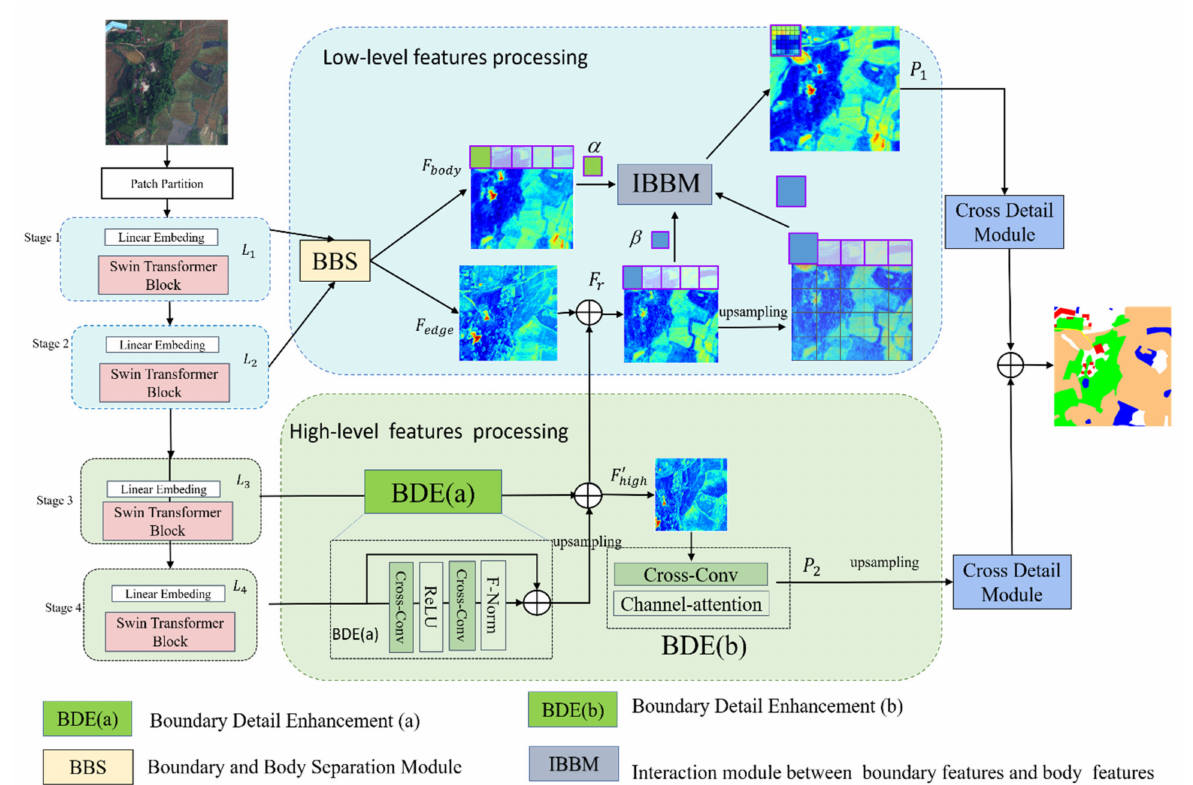
Figure 3. Overall structure of HBRNet. The figure shows the main modules for processing high-level features and low-level features. After inputting the original map, two level features are output through a hierarchical structure, and the feature map is processed separately. The output features of Swin Transformer from the first stage to the fourth stage as { L 1 , L 2 , L 3 , L 4 } . F body stands for body features. F edge stands for boundary features. F (cid:48) represents the features obtained after the BDE high (a) for the high-level features. F r represents the features generated by the combination of boundary features and F (cid:48) . P 1 represents the features generated after the low-level feature processing. P 1 high represents the features generated after the low-level features processing. P 2 represents the features generated after the high-level features processing. F-Norm stands for feature normalization. ReLU stands for rectified linear unit. Cross-Conv stands for